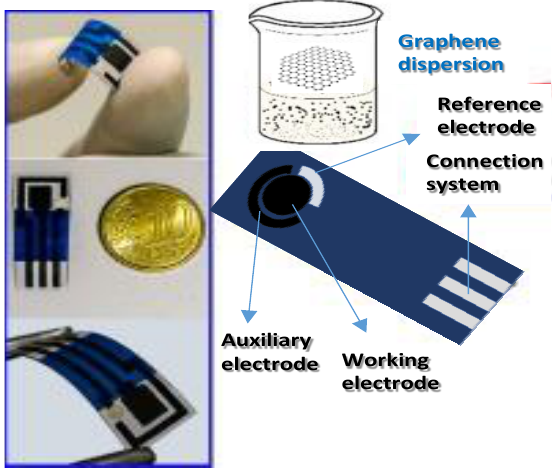
Figure 3. Graphene-coated carbon screen-printed electrode (G-CSPE) with the three-electrode system: a reference electrode, a working electrode, and an auxiliary or counter electrode.